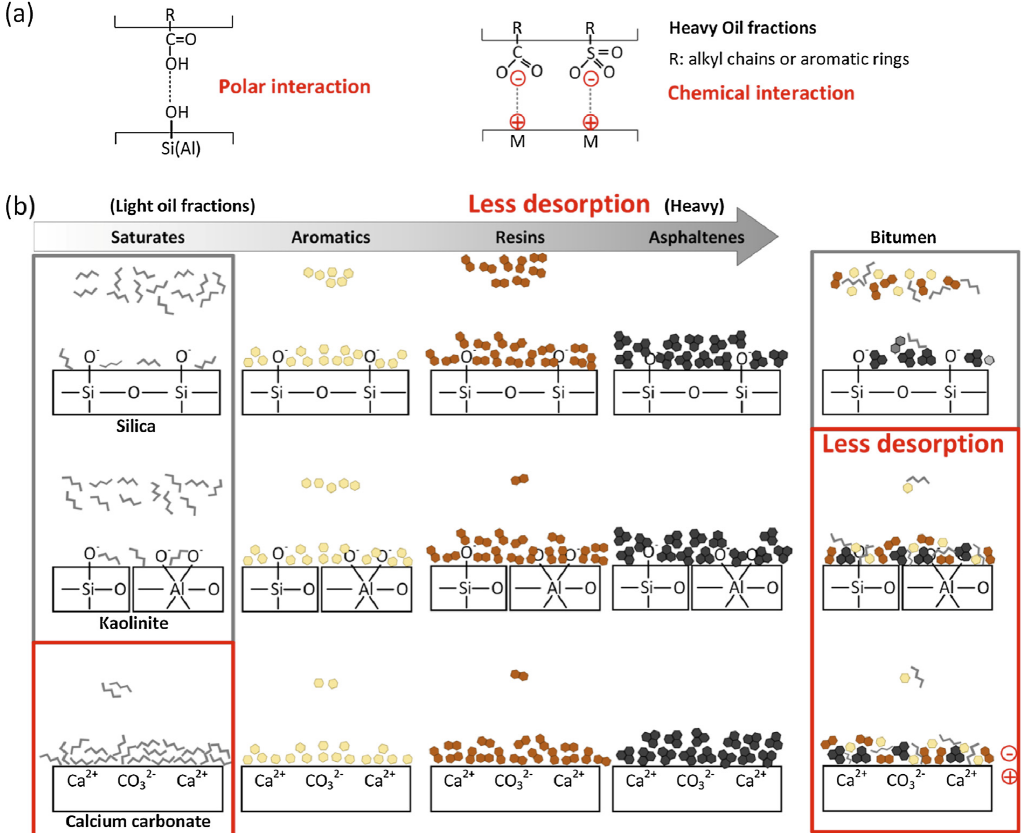
Figure 23. Schematics of ( a ) adsorption polar and chemical interactions between oil fractions and silica and kaolinite; ( b ) desorption properties of SARA and bitumen on silica, kaolinite and calcium carbonate in aqueous solutions. Reprinted with permission from Ref. [199]. Copyright 2018, copy- right the Elsevier. More details on Copyright and Liscensing are available via the following link: https://linkinghub.elsevier.com/.